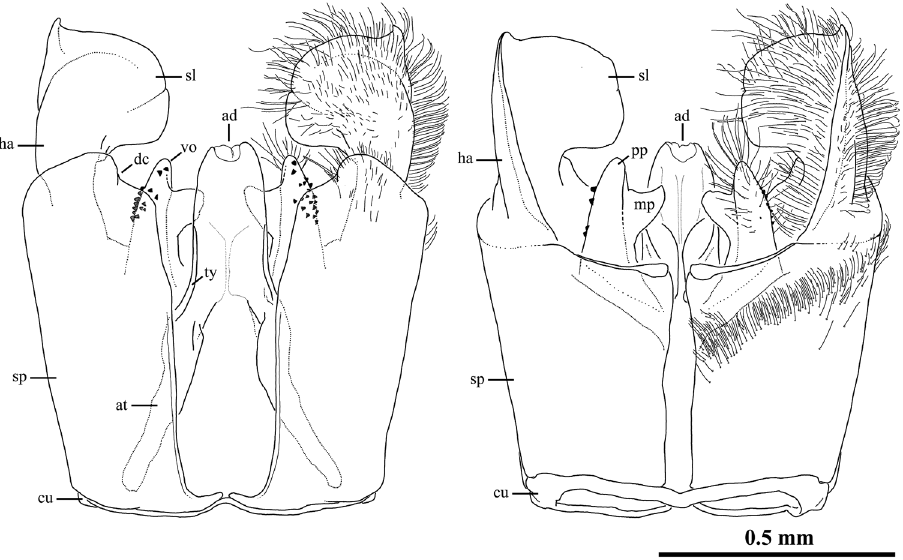
Figure 10. Male genital of Celonites hermon (dbM No. 3689) in dorsal (left) and ventral view (right). Setae only shown on one side of each drawing. Nomenclature follows that of Birket-Smith (1981): ad, ae- doeagus; at, apodema thyrsos; cu, cupula; dc, dorso-medial concavity of the posterior margin of the stipes; ha, harpide; mp, medial process of volsella; pp, posterior process of volsella; sl, shovel-like dorso-medial lobe of harpide; sp, stipes; ty, thyrsos; vo,